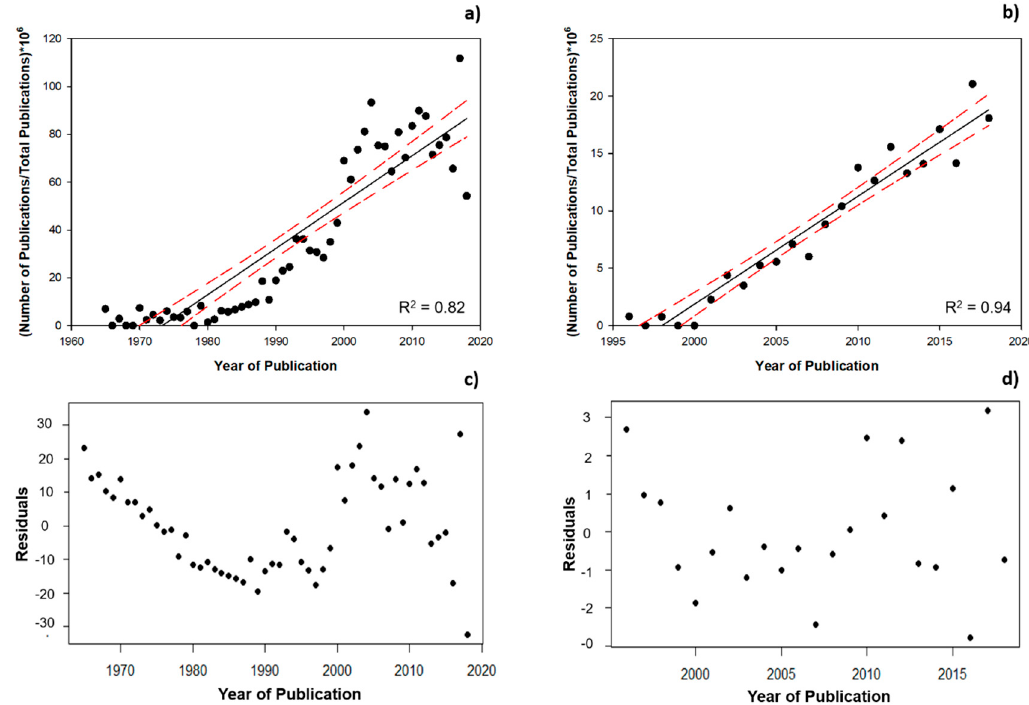
Figure 2. Variation in the total number of publications, per annum, between 1965 and March 2018, that ( a ) used cpDNA sequences as markers, and ( b ) used cpDNA markers to obtain estimates of genetic diversity, and the residuals (per annum) of the regression models for the studies that ( c ) used cpDNA sequences as markers, and ( d ) used cpDNA markers to obtain estimates of genetic diversity.